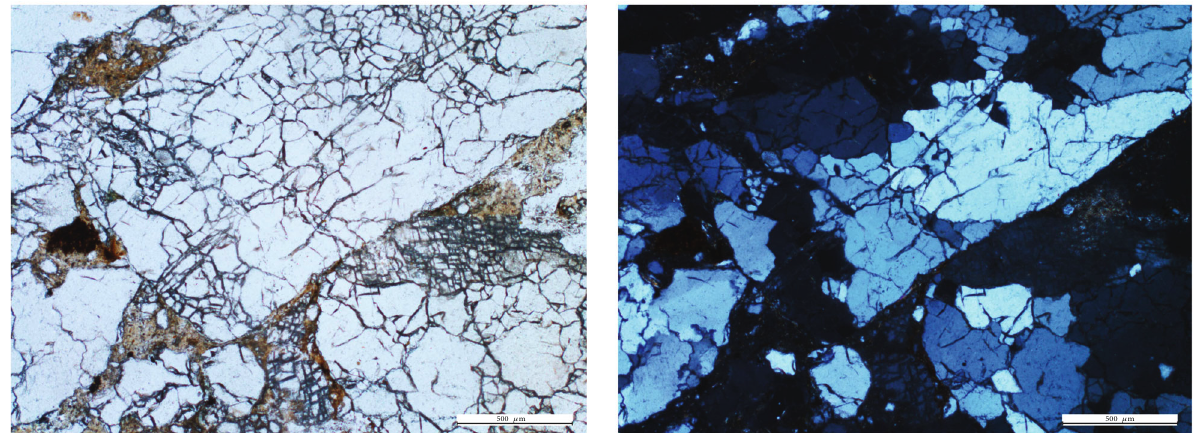
Figure 1: Thin section of core casting of L